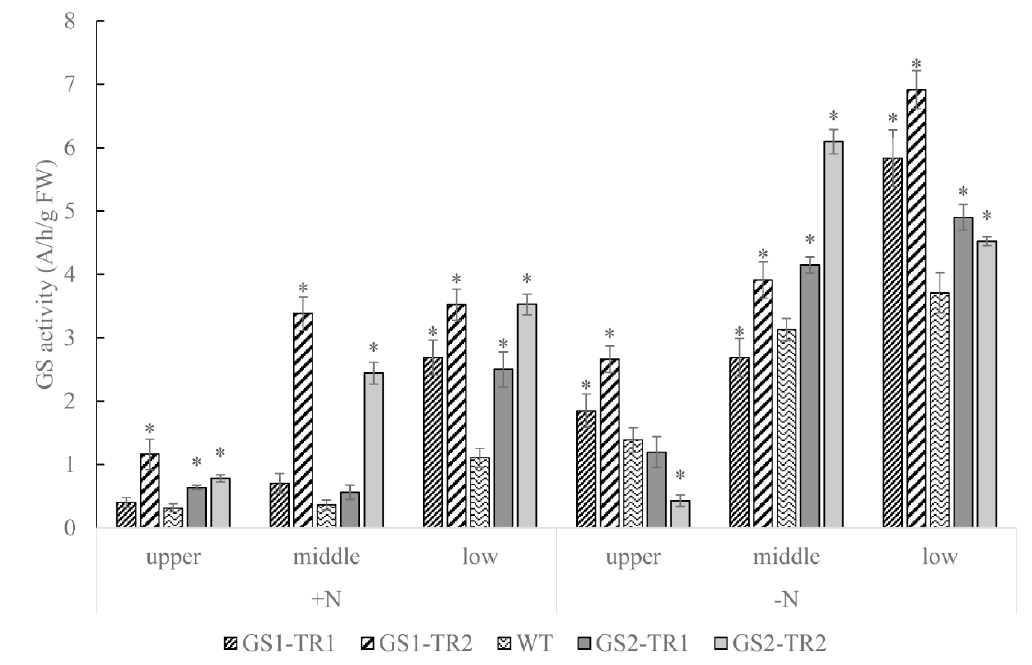
Figure 5. The GS activity in the upper, middle and lower leaves of GS1-TR and GS2-TR compared with that in the WT grown under a N+ or N − regime. Each value is the mean ± standard error of three replicates. Asterisk indicate that the date is significantly different ( p < 0.05) from the data of WT plants.